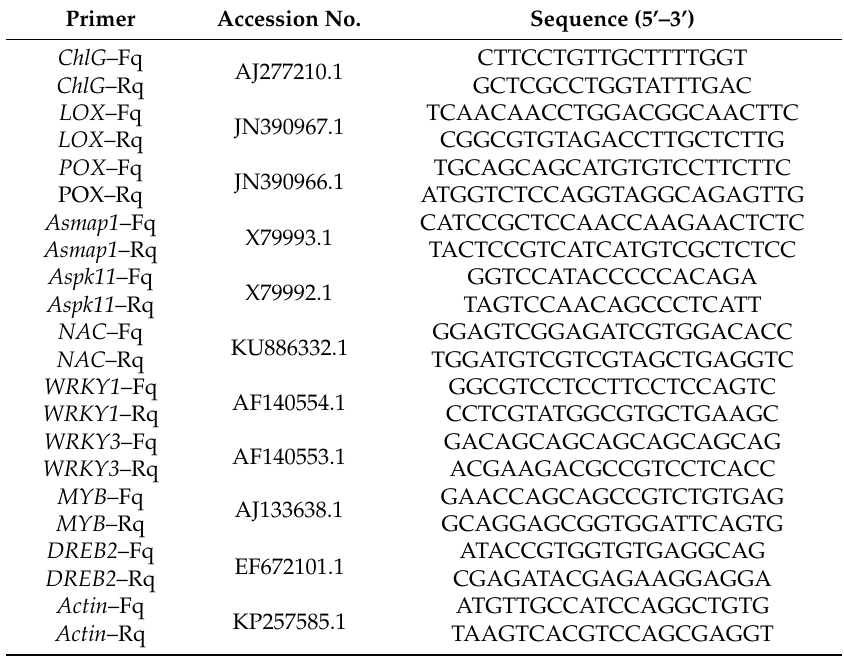
Table 1. Salt-tolerance relative genes and primers used in quantitative real-time RT-PCR analysis. Primer Accession